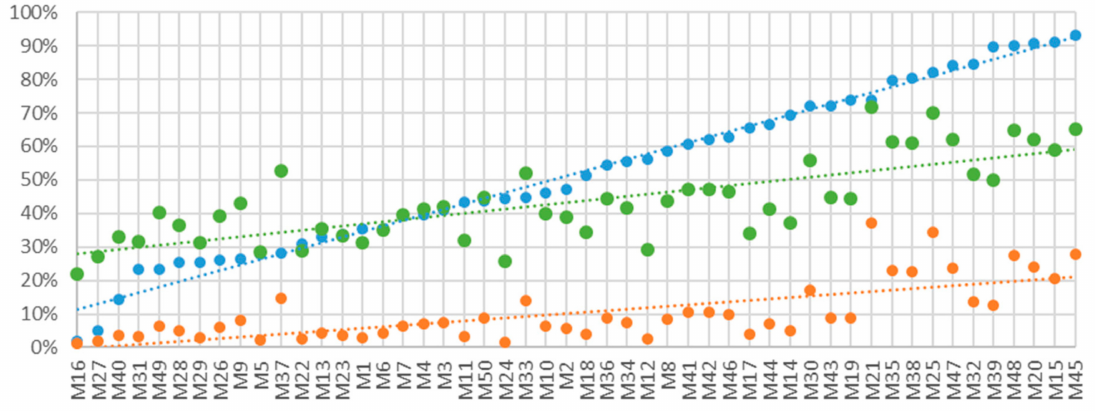
Figure 13. User-perceived values (L UP , marked blue), map load values measured by ED1 metric (L ED1 , marked orange) and ED3 metric (L ED3 , marked green) sorted in ascending order by L UP . Dotted lines indicate trends.